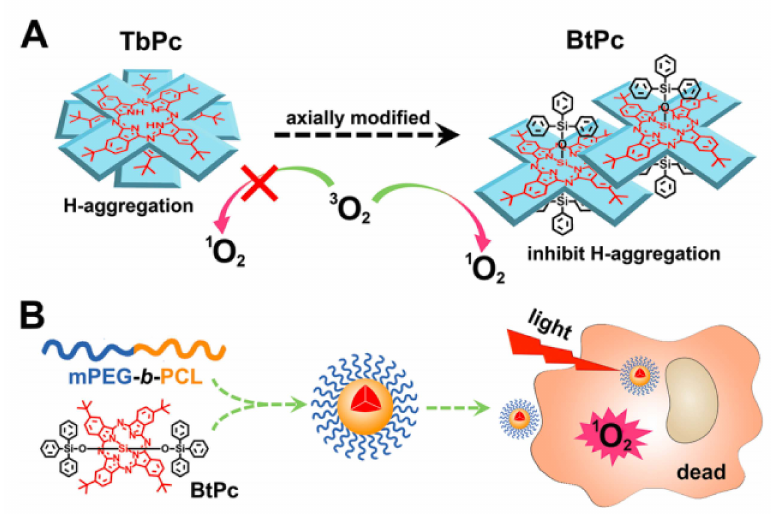
Scheme 10. Schematic illustration of: ( A ) the aggregation patterns of different phthalocyanines and their effect on 1 O 2 generation; ( B ) self-assembly of mPEG-b-PCL and BtPc for PDT. Reprinted with permission from ref [25]. Copyright 2018 The Royal Society of